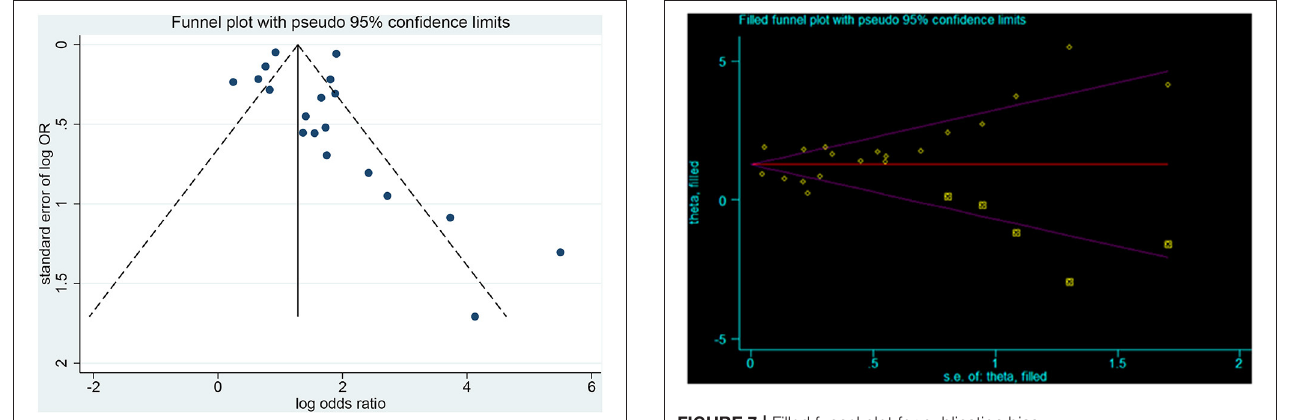
FIGURE 6 | Funnel plot for publication bias.